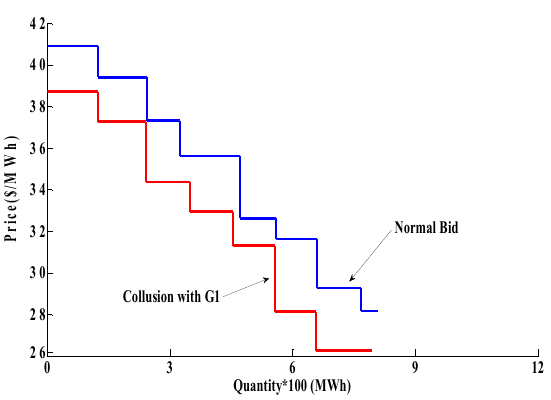
Figure 7. Bids of G1 as per Case B: ( a ) When D2 remains loyal; ( b ) when D2 does not remain loyal.